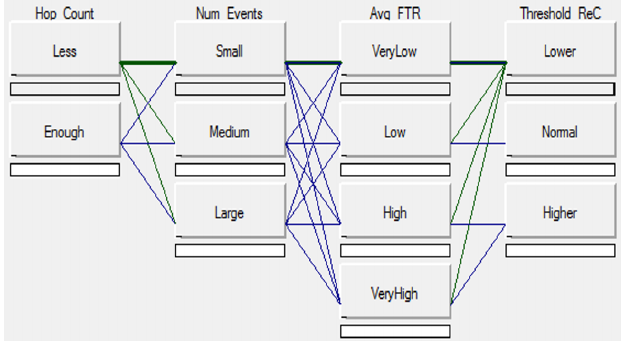
Figure 4. Fuzzy members, fuzzy sets, and rules for re-clustering.